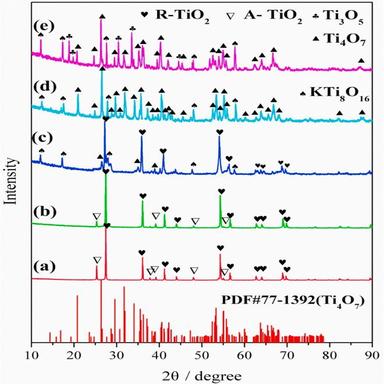
XRD patterns of the TiO2 coating (a) before and after sintering at different temperature for 1 h, (b) 800 ◦C, (c) 900 ◦C, (d) 1000 ◦C, and (e) 1100 ◦C.